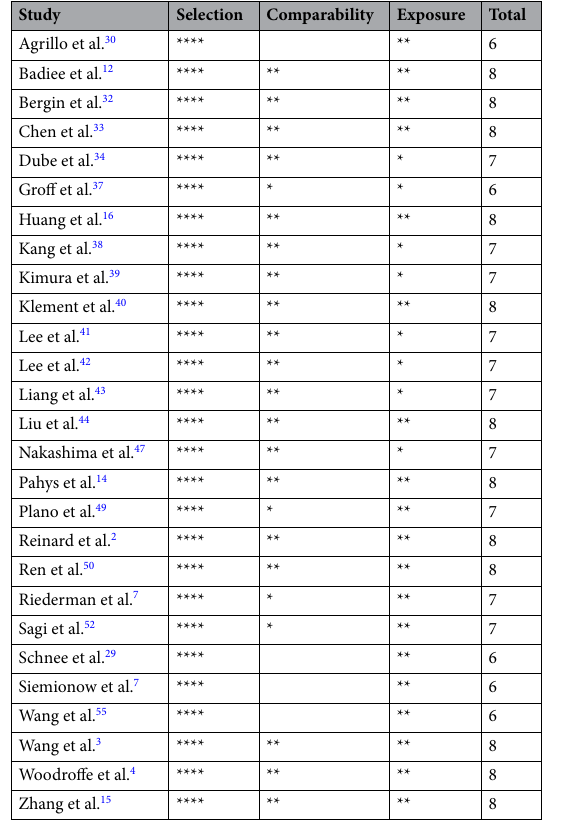
Table 2. Quality assessment of case–control studies according to Newcastle–Ottawa scale.